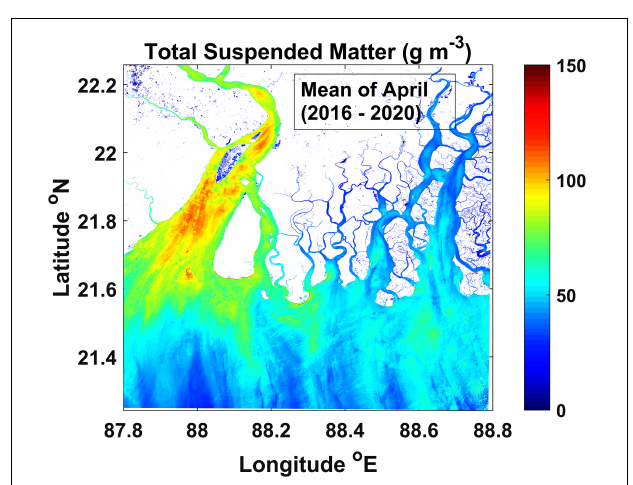
FIGURE 4 | Mean TSM concentration during April for the period 2016–2020 derived from Landsat-8/OLI.